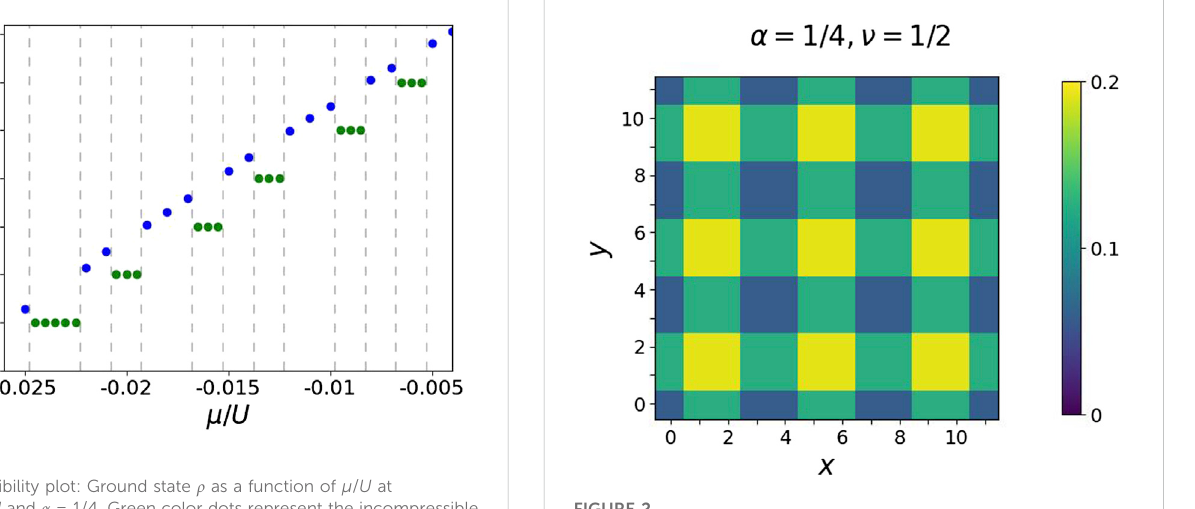
FIGURE 2 Densitydistributionforthe ] =1/2incompressiblestateat μ / U = − 0.02 obtained by CGMF with the 4 × 4 cluster for a 12 × 12 lattice with